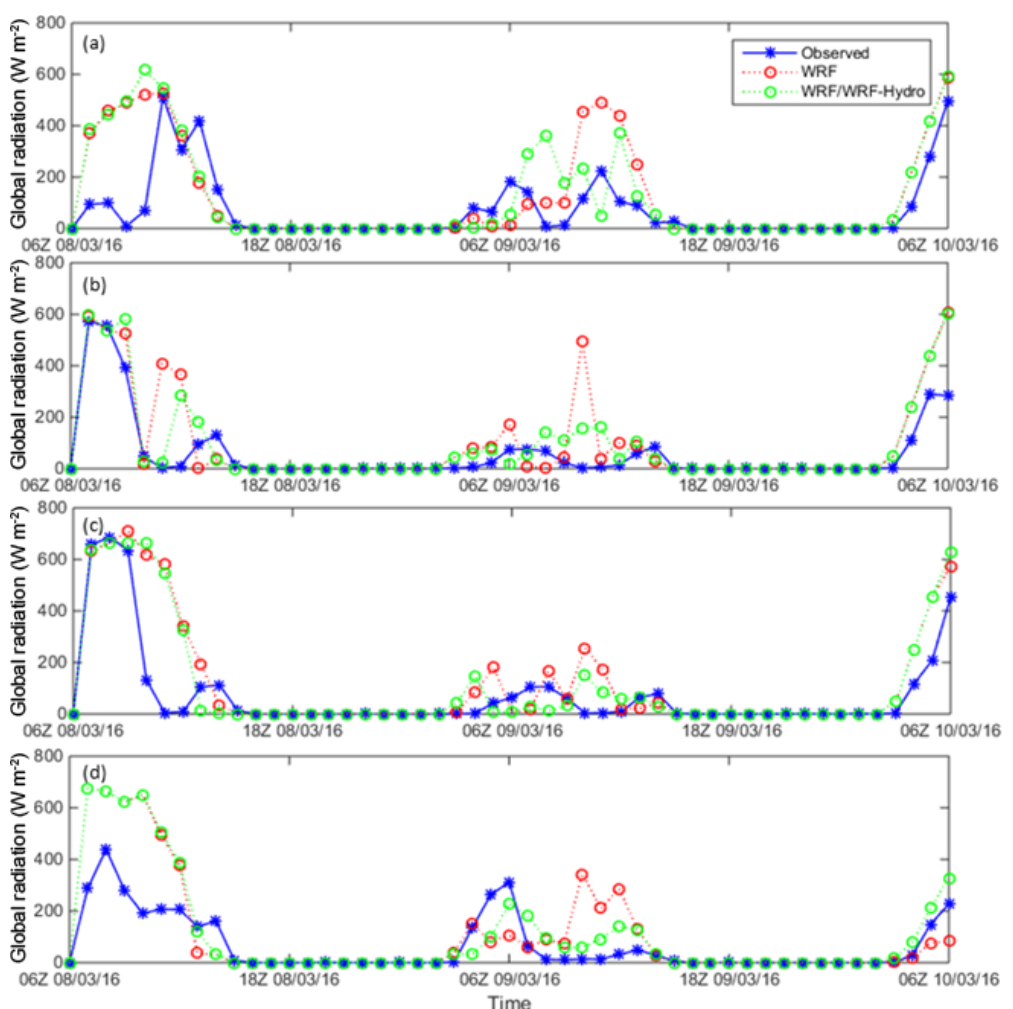
Figure 7. Comparison of global radiation observations at Abu Dhabi (a) , Al Ain (b) , Jabal Hafeet (c) , and Jabal Mebreh (d) stations with WRF and WRF–WRF-Hydro simulations. Table 5. Global radiation statistical measures from the stations and simulations at 15min intervals ( n = 194). Global radiation Mean Min. Max. SD PCC RMSE rBIAS Source (Wm − 2 ) (Wm − 2 ) (Wm − 2 ) (Wm − 2 ) Station observations 101.96 0 985.05 WRF